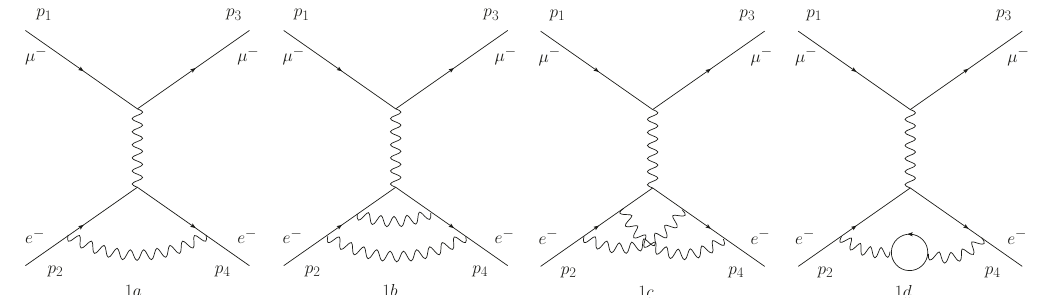
(cid:22)e scattering. One-loop correction !